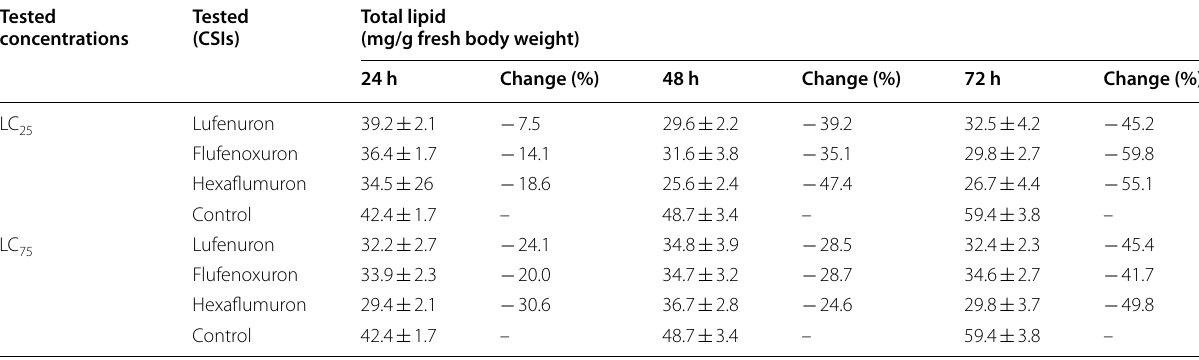
Table 4 Effect of lufenuron, flufenoxuron and hexaflumuron on the total lipid content of the house fly M. domestica penultimate larval instar treated with the LC and LC concentrations at different time intervals 25 75 Tested